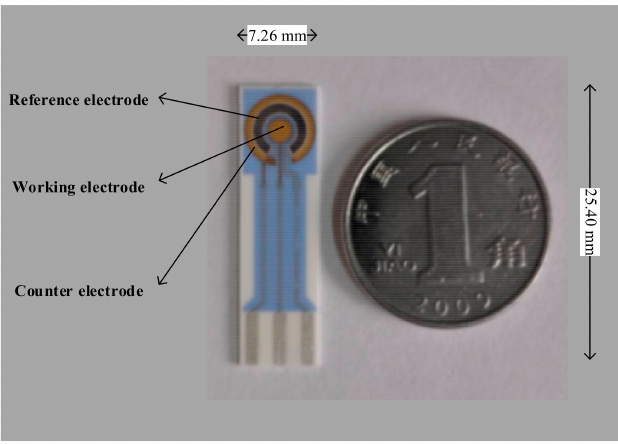
Figure 1. Size and real object of screen printed gold electrode (the right is the Chinese currency worth 0.1 Yuan, which is the minimum coin of China in circulation).